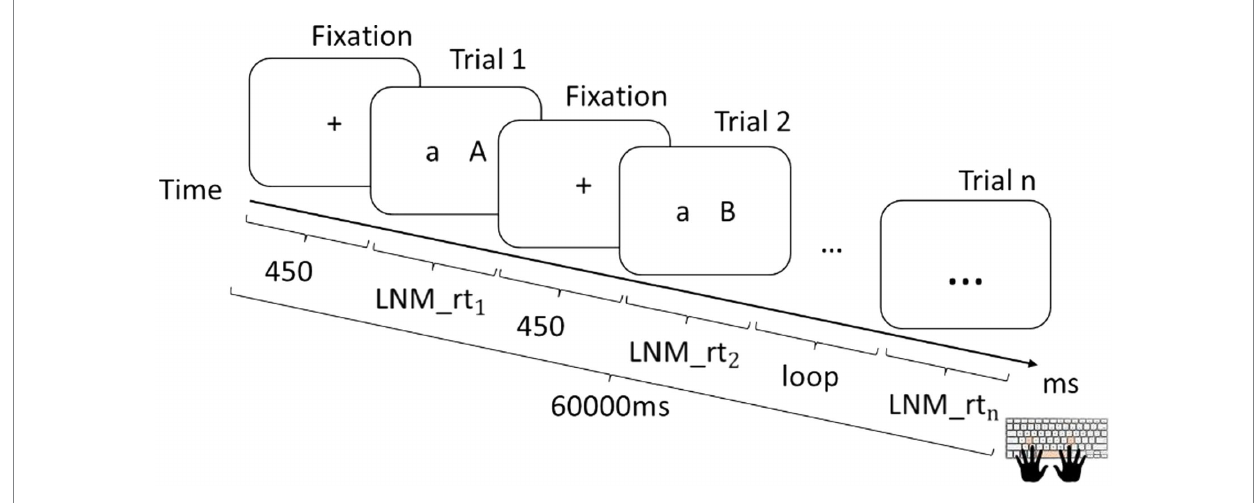
FIGURE 3 Trial sequence of the LNMtask. rt, reaction time.